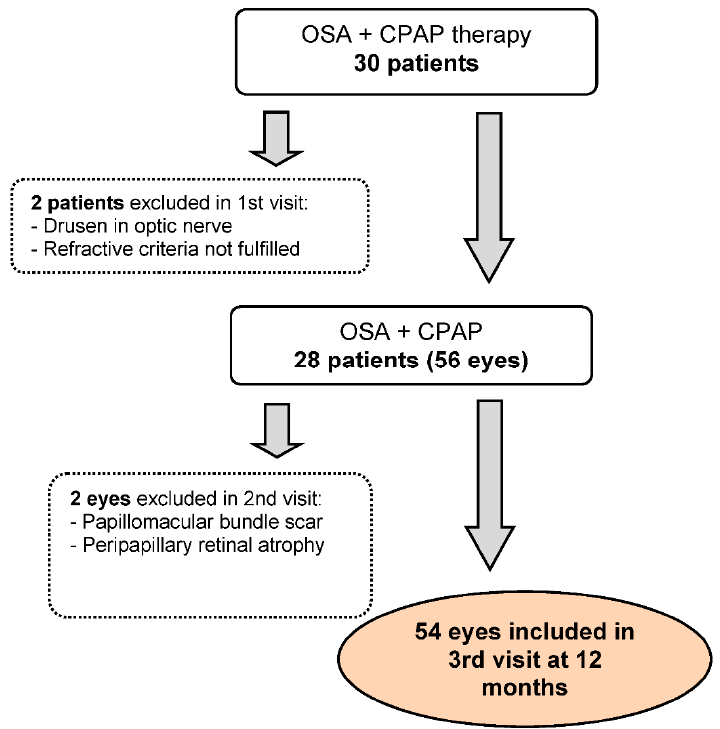
Figure 1. Enrolment of patients with obstructive sleep apnea (OSA) subjected to continuous positive airway pressure (CPAP) treatment. Table 1. Baseline characteristics of the patients with obstructive sleep apnea included in this